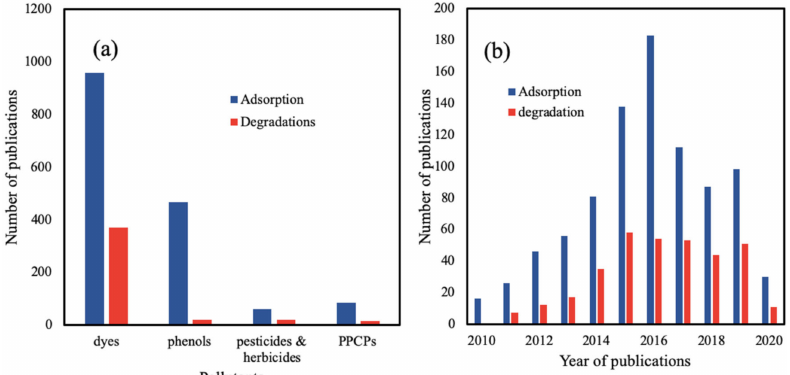
Figure 11. Patents granted from 2010 to 2020 on the adsorption and photocatalytic degradation using MOFs-based materials of ( a ) some emerging pollutants and ( b ) dyes. Data obtained from the lens.org using keywords MOFs, adsorption, photocatalytic degradation, dyes, phenols, PPCPs, pesticides, and